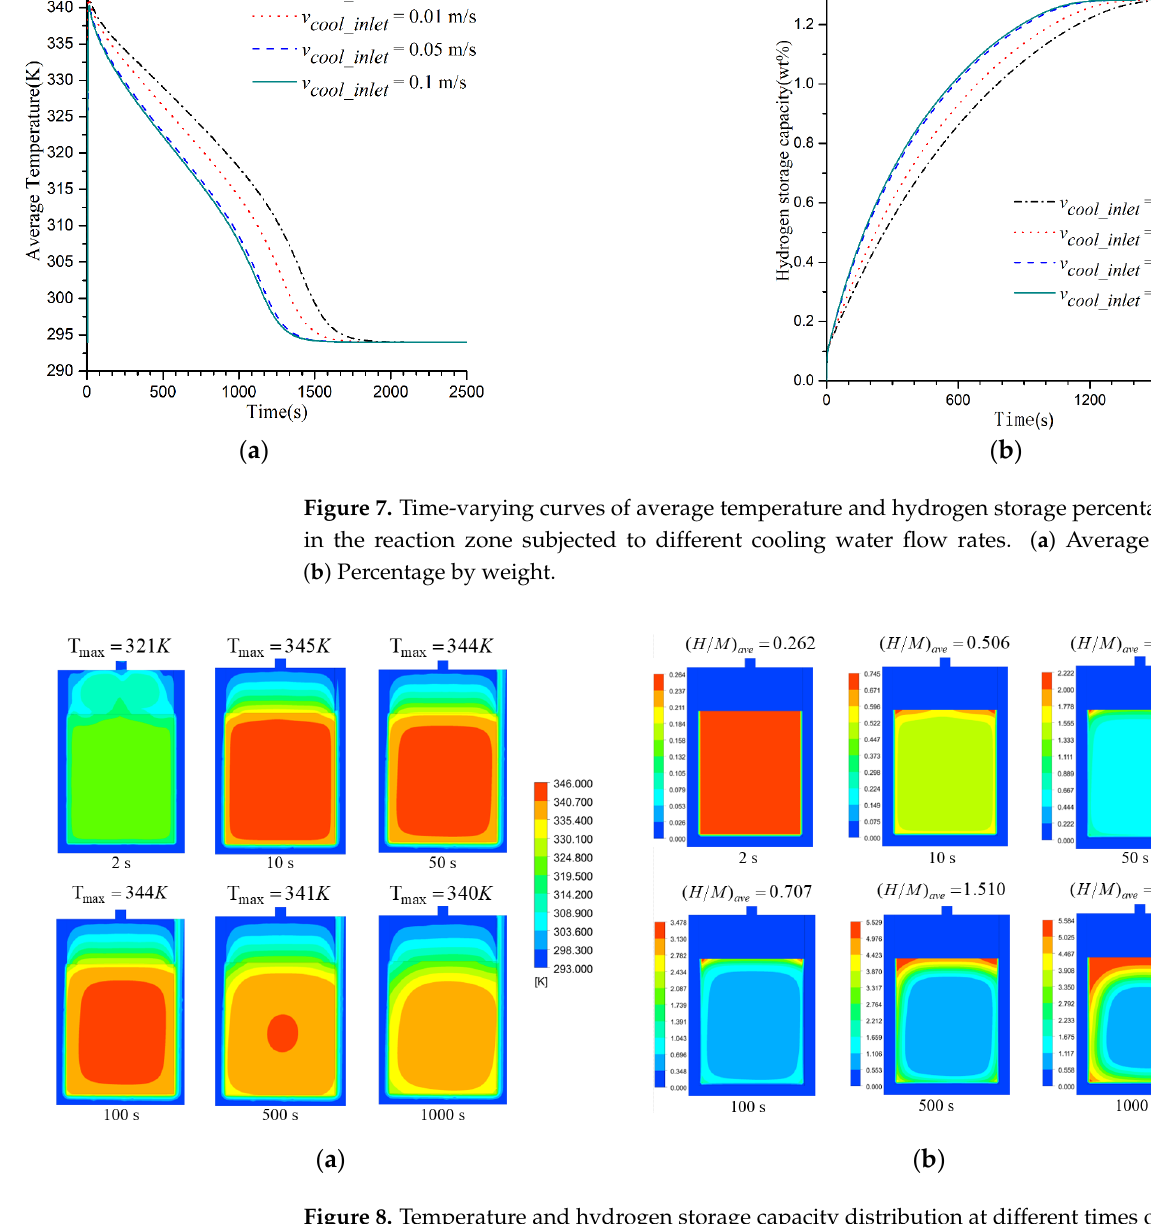
( b ) Figure 9. Temperature and hydrogen storage capacity distribution at different times of the reaction tank subjected to an oil coolant flow rate of 0.01 m/s. ( a ) Temperature distribution cloud chart; ( b ) Hydrogen storage capacity distribution cloud chart.